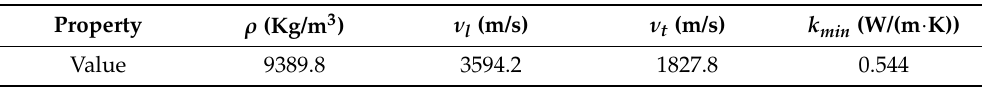
Figure 6. Heat capacity of Ag 9 In 4 as a function of temperature. Table 7. Mass density, longitudinal, transverse sound velocities and minimum thermal conductivity of Ag 9 In 4 .